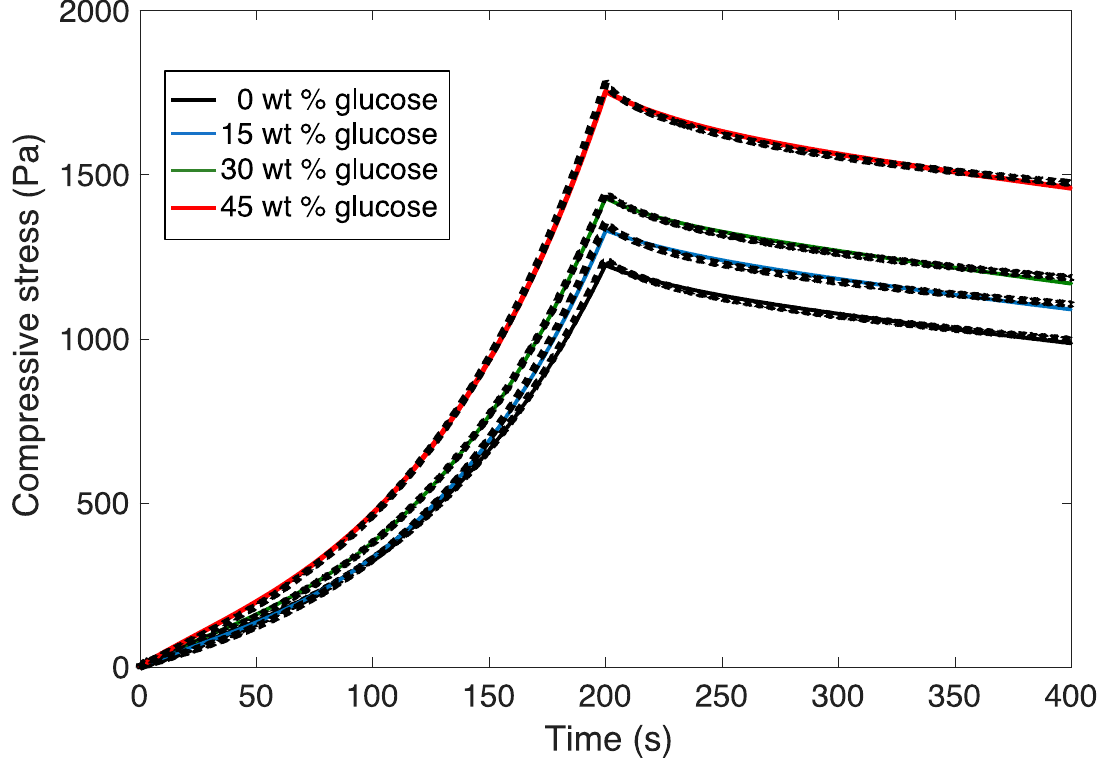
Figure 5. Compression–relaxation curves of calcium-alginate gels with different glucose concentra- tions. The dashed back line represents the experimental data. Solid lines are the model predictions.